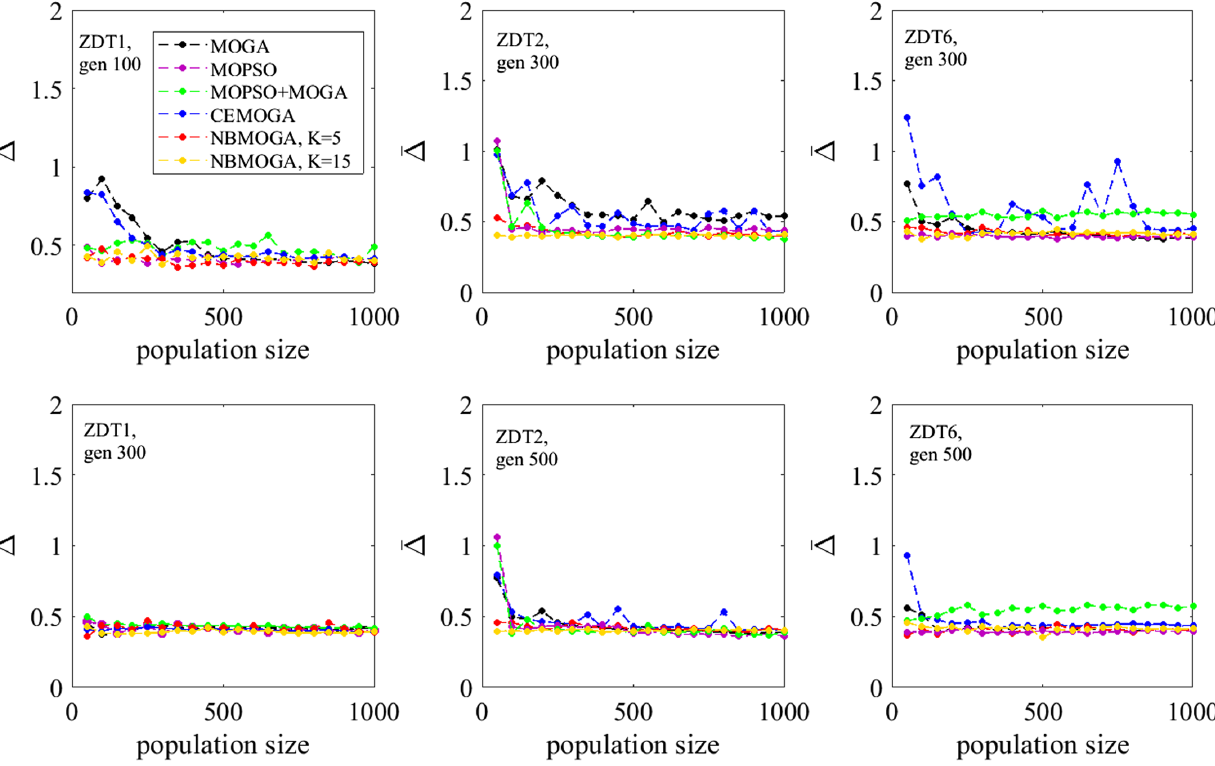
¯ Δ with the population size, where